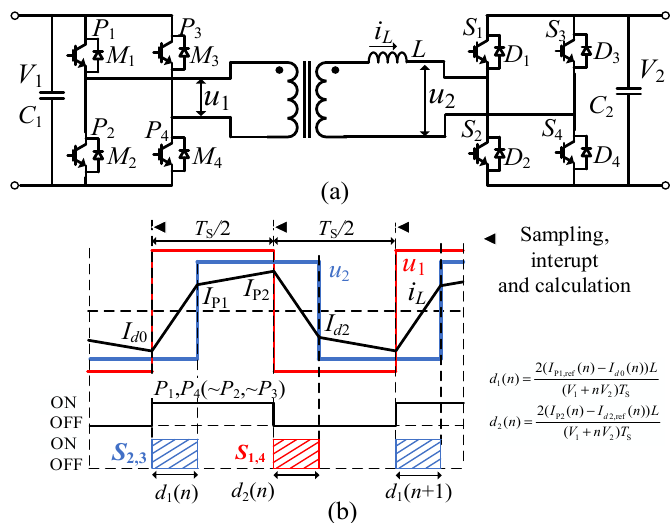
Figure 1. Principle of the PDCM controller. ( a ) IBDC, ( b ) waveforms.